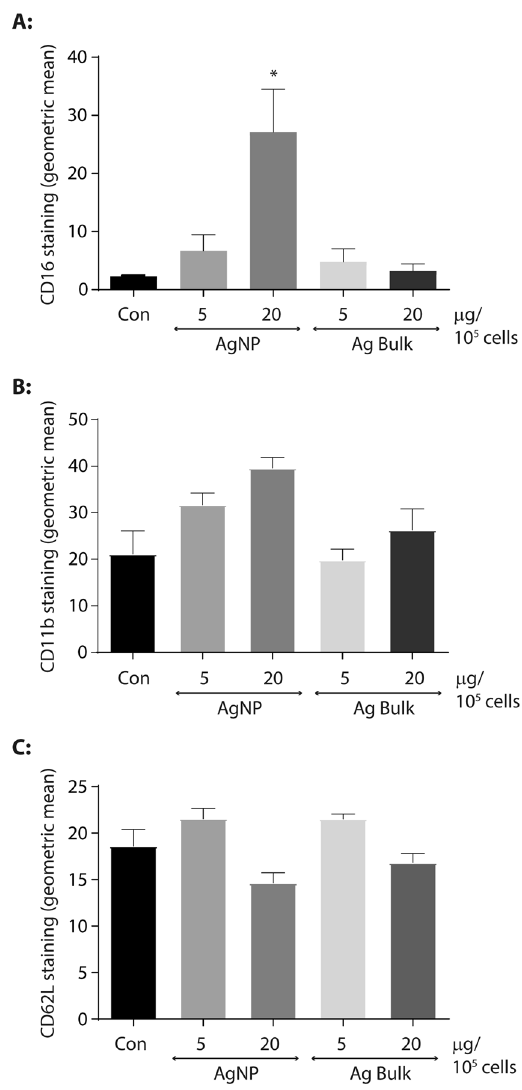
population of untreated human neutrophils (Con) or following treatment with 5 or 20 µ g AgNP or Ag Bulk particles per 10 5 cells for 20 hr at 37 °C. Data is presented as the geometric mean ± SEM, where n = 3; * p <